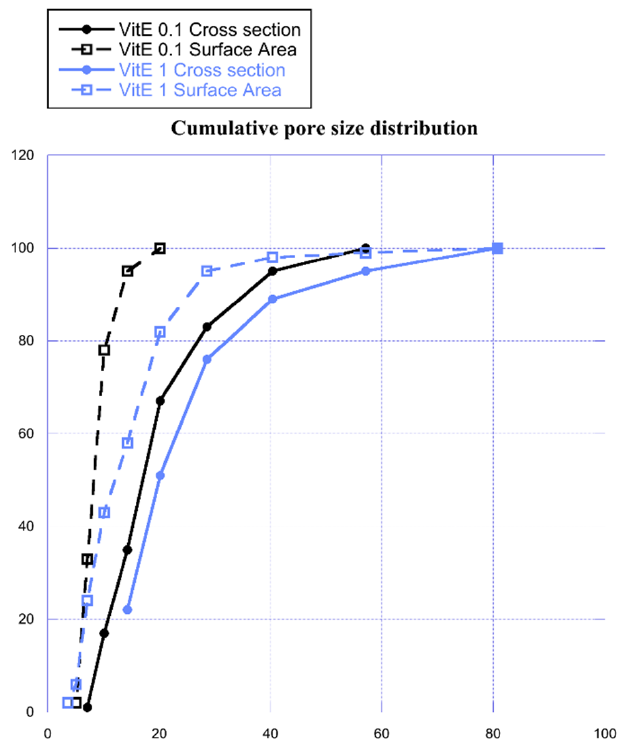
Figure 4. Cumulative pore size distribution in cross section ( dot ) and on the surface ( empty square ) of VitE 0.1 ( black ) and VitE 1 ( light blue ) scaffolds.